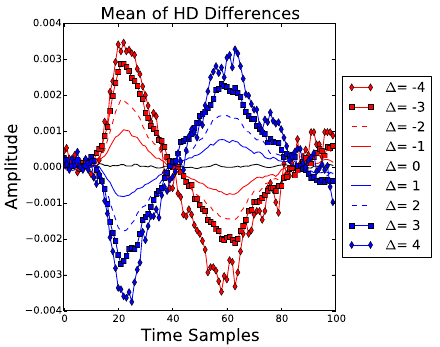
Figure 16: Investigating ∆ HD to distin- guish sign of the